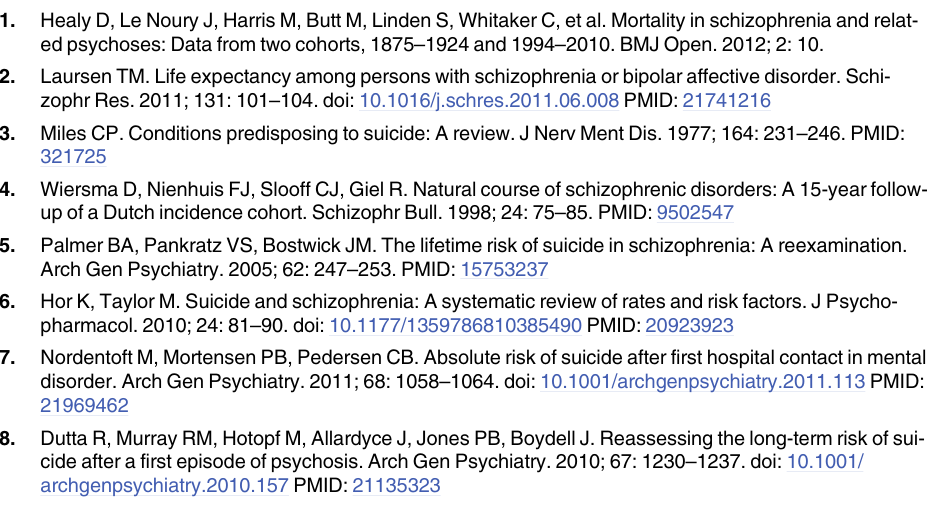
S1 Table. Demographic data of subjects whose status was known at the end of the measure- ment period (n = 424) and subjects whose status was unknown (n = 190). The last column contains demographic information of Wiersma et al. (1998) for comparison. S2 Table. Pooled results of Cox regression analysis of imputed dataset (n = 10). S1 Dataset. Dataset used for the survival analyses. Both recent dataset and the dataset of Wiersma et al. (1998) are